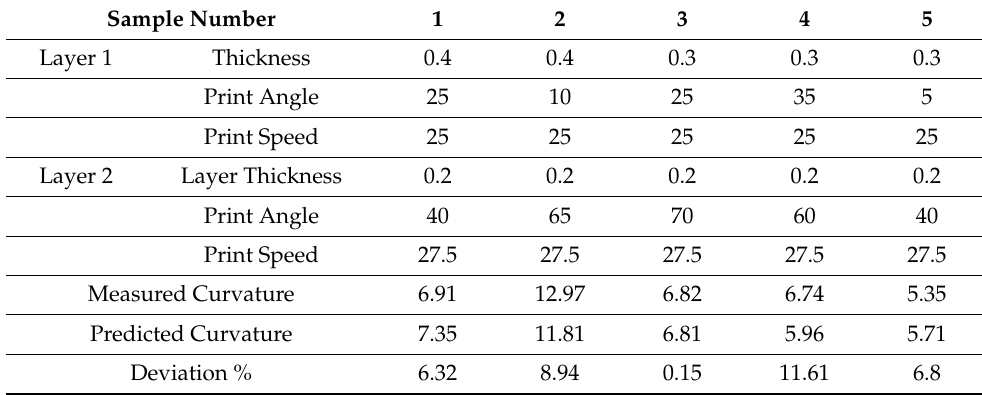
Table 4. Curvature comparison based on the prediction model and the experimental analysis.